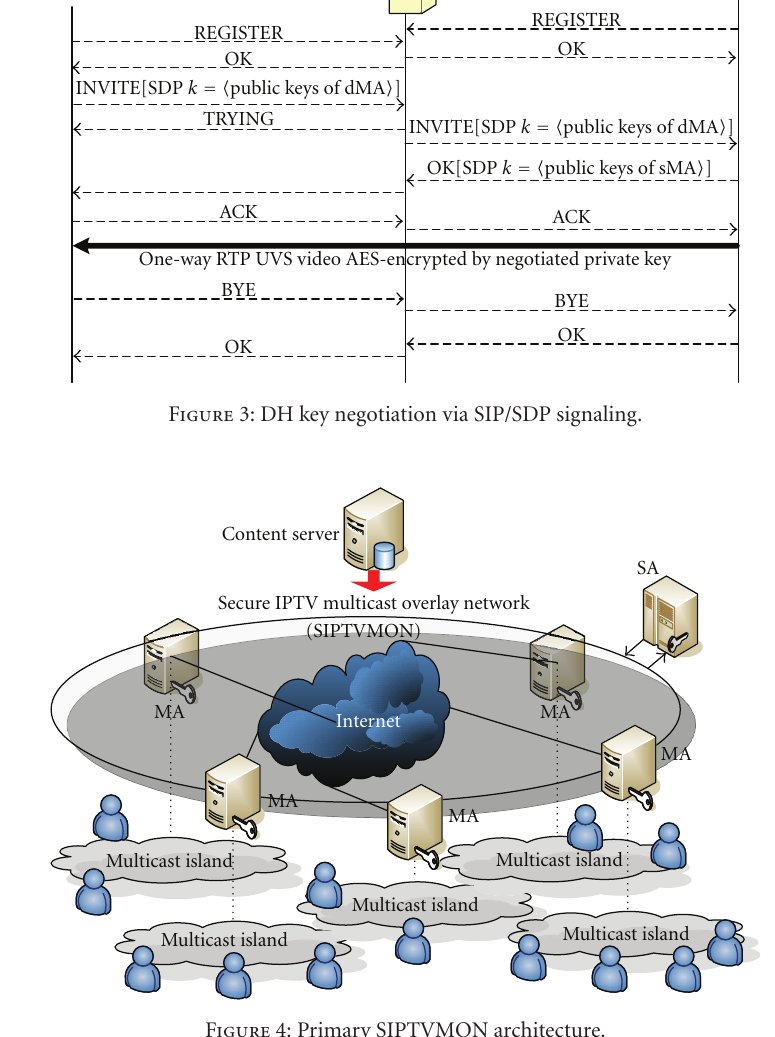
Figure 4: Primary SIPTVMON